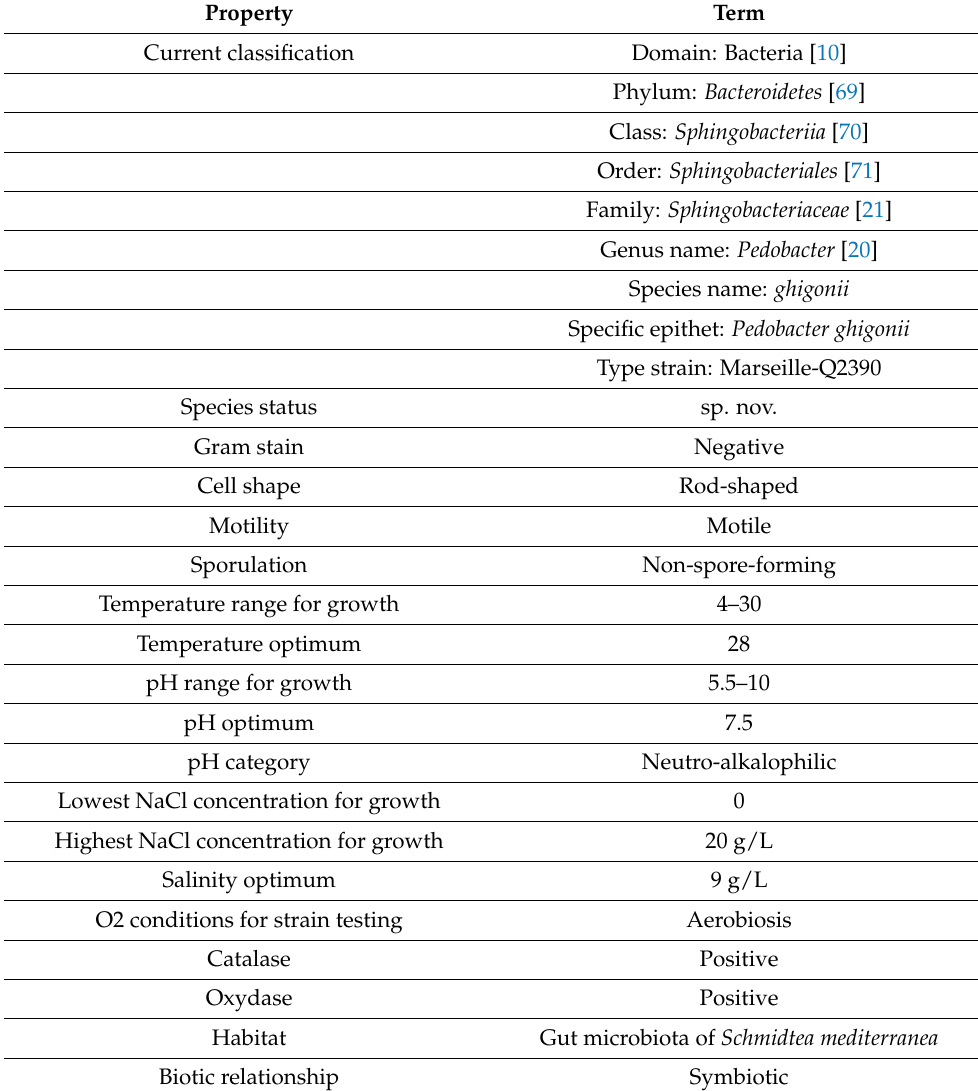
Table 2. Classification and general features of the strain